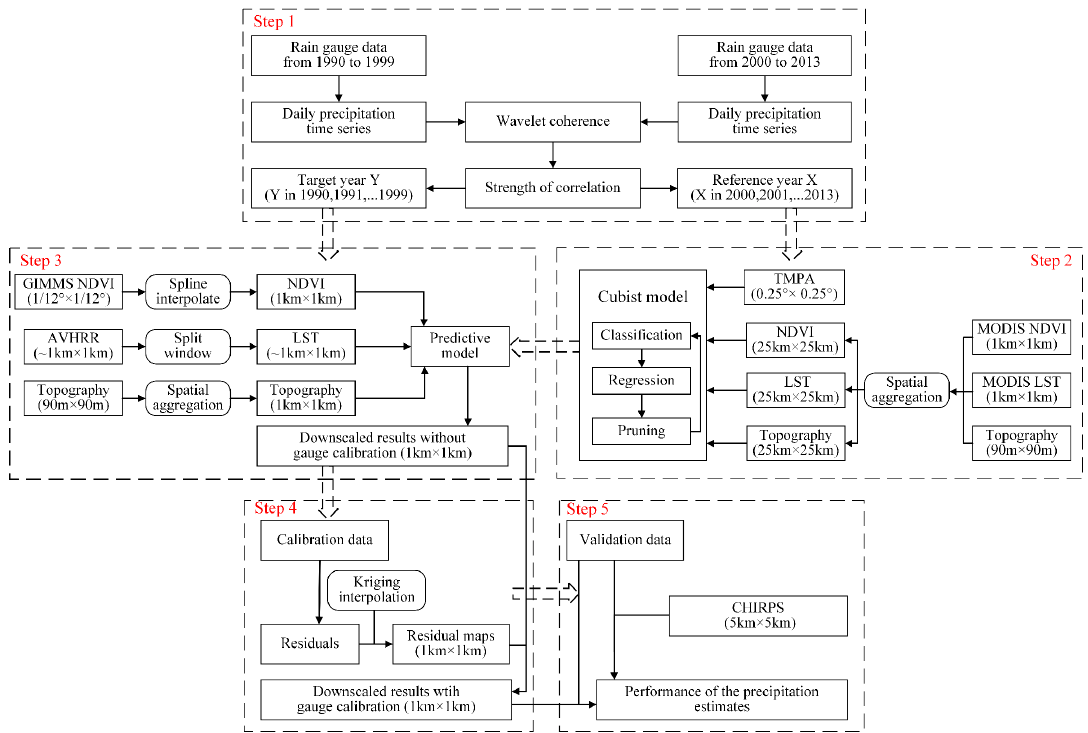
Figure 2. Flow chart for obtaining retrospective precipitation estimates at ~1 km, in 1990s, using wavelet coherence and Cubist.